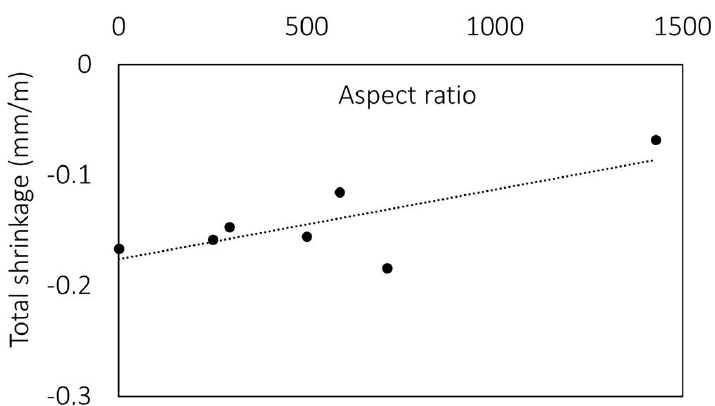
Figure 11. Influence of fibre aspect ratio on the total shrinkage values at the age of 3